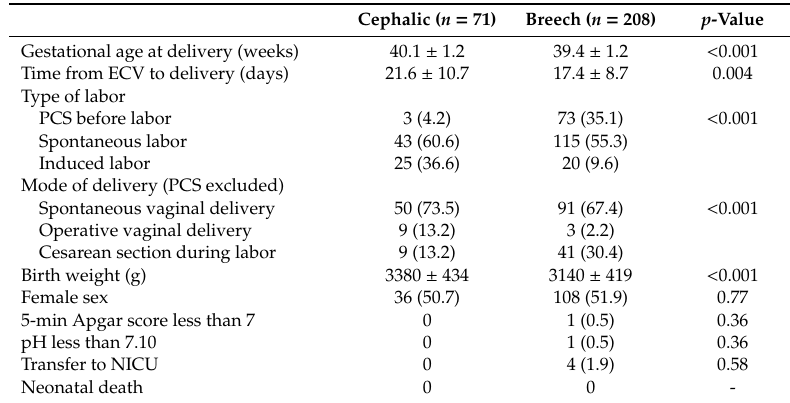
Table 3. Labor characteristics and neonatal outcomes after attempted external cephalic version for a breech presentation at term, according to presentation at delivery. Cephalic ( n = 71) p